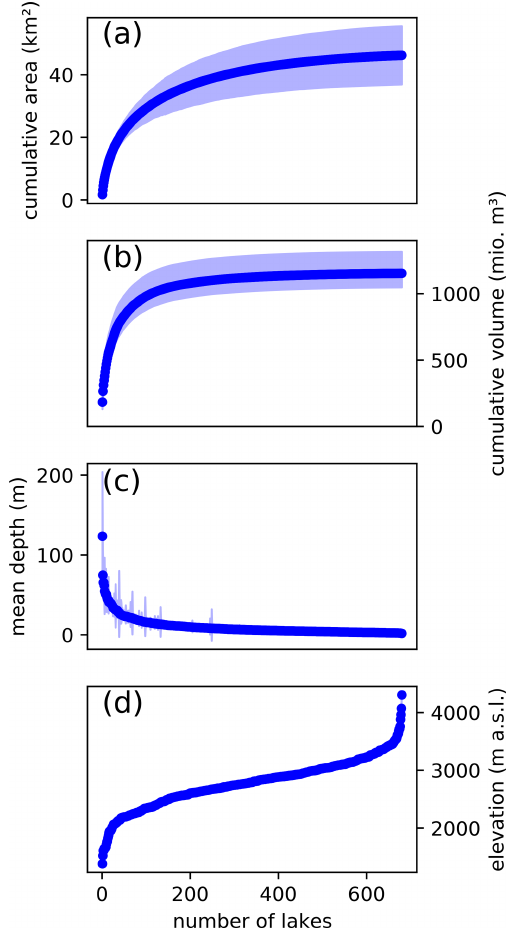
Figure 2. Cumulative area (a) and volume (b) of all potential lakes identified within the perimeter of the SGI2016 (Linsbauer et al., 2021). The cumulative uncertainty is given by the shaded bands. Distribution of (c) average depth and (d) elevation of the maximal lake level of all potential lakes. In panel (c) , shaded bars show the uncertainties of each individual lake, whilst in panel (d) the uncer- tainty is too small to be seen ( < 80m in all cases). Note that all pan- els refer to the ice-free topography, i.e. to the hypothetical situation in which all glaciers would melt